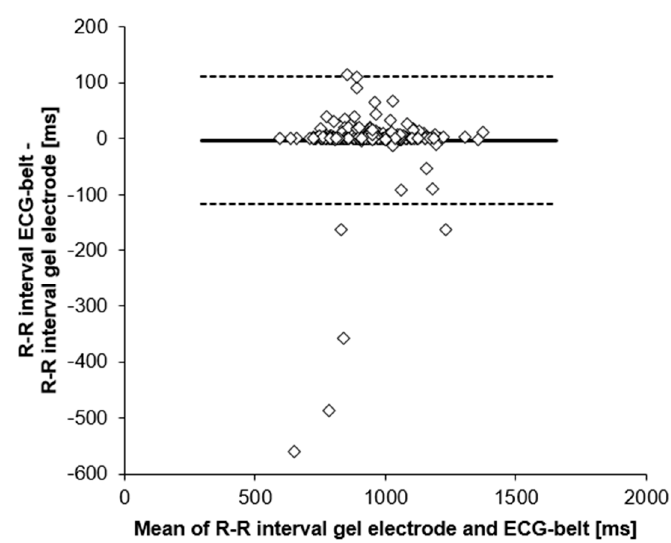
Figure 4. Bland-Altman plot of RR-intervals measured using gel electrodes and the ECG-belt. Solid line, mean difference; dashed lines, upper and lower 95% confidence intervals. Table 2. Mean values for a signal to noise ratio for low (SNRlf) and high-frequency noise (SNRhf), as well as baseline wander (BLW).